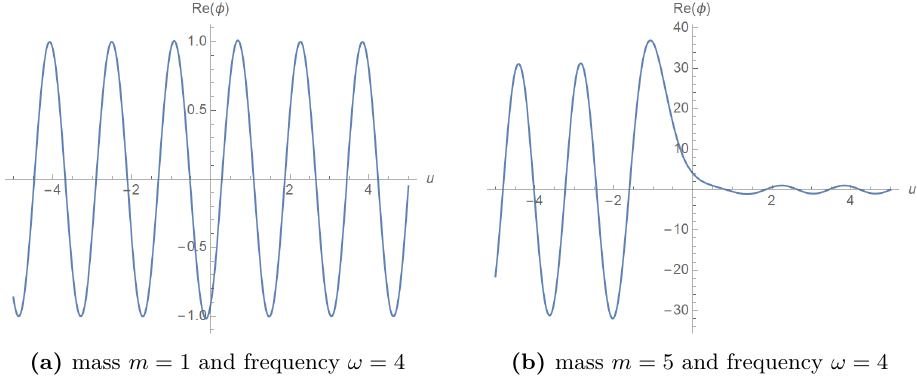
Figure 4. We plot the real part of the scalar solution φ which is outgoing at x = 1 , in the case where the field E = 0 , at time t = 0 . For larger mass transmission is suppressed.